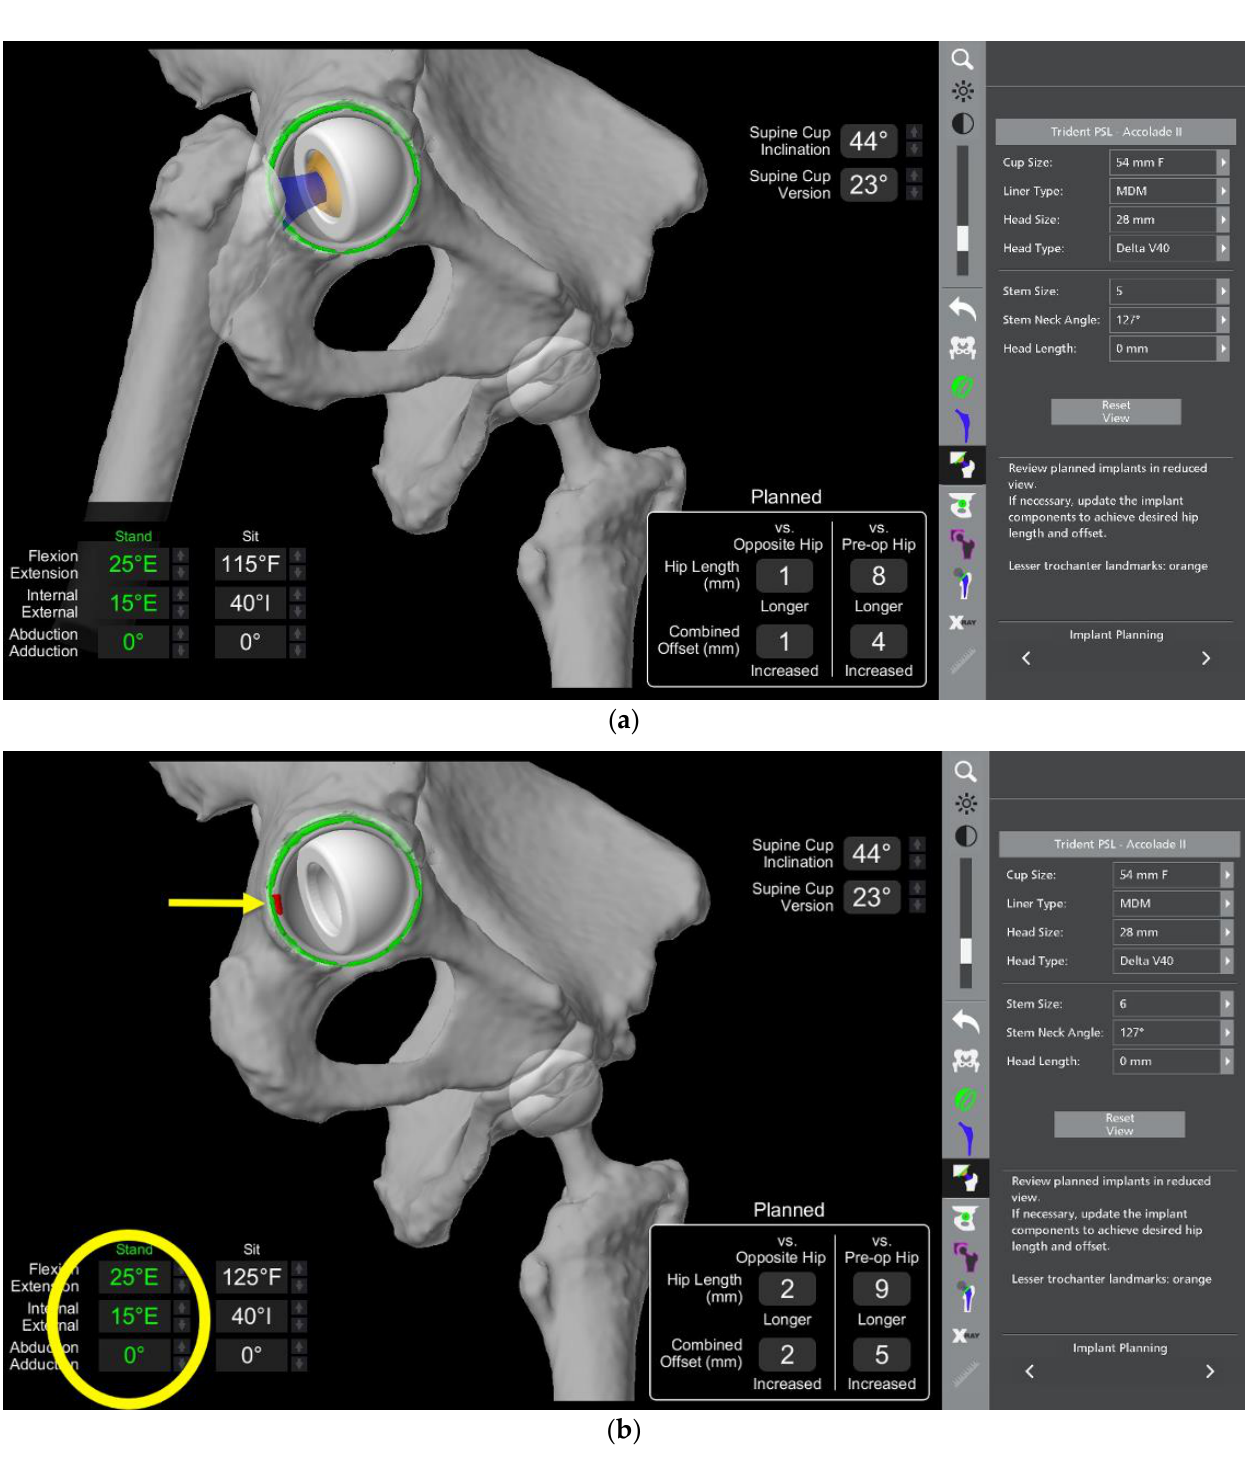
Figure 11. ( a ) VROM in extension with no obvious impingement. ( b ) VROM in extension (yellow circle) with subtraction of the implant showing a small area of anterior impingement (red area indicated by yellow arrow).